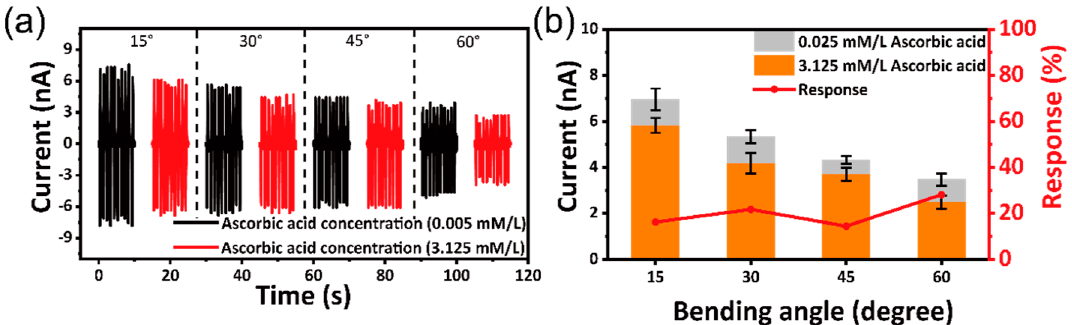
Figure 4. ( a ) Output triboelectric current of self-powered flexible sour sensor under different bending angles. ( b ) The relationship between bending angles and response.